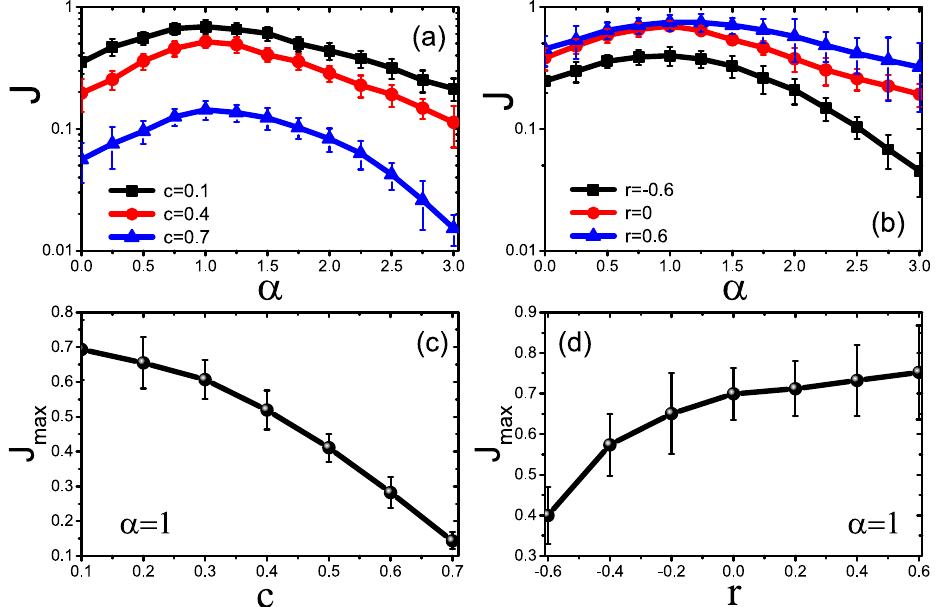
Figure 5. Influence of the clustering coefficient c and assortativity coefficient r on the total heat flux J for N = 300 and � k � = 4 , with averaging over 50 realizations and randomly chosen source nodes. ( a ) represents the influence of c on J where the “squares”, “circles” and “triangles” represent the cases of c = 0.1, 0.4 and 0.6, respectively. ( b ) represents the influence of r on J where the “squares”, “circles” and “triangles” represent the cases of r = − 0.6, 0 and 0.6, respectively. ( c ) Dependence of J max on c for α = 1 . ( d ) Dependence of J max on r for α = 1